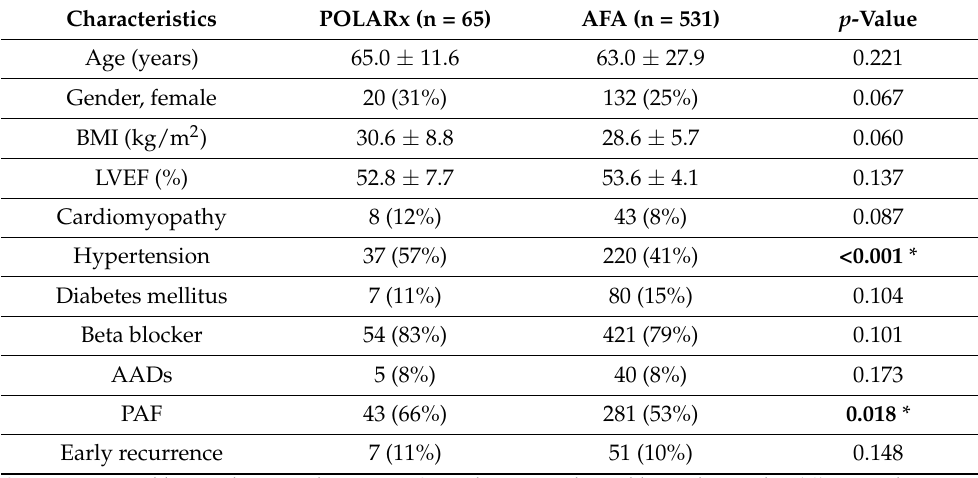
Table 2. Baseline characteristics.